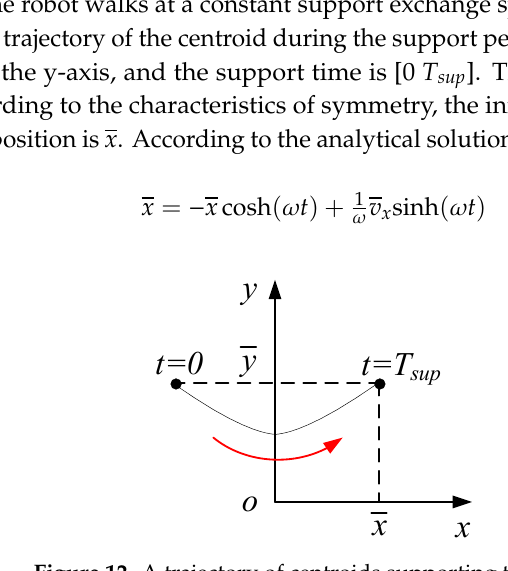
Figure 12. A trajectory of centroids supporting the cycle.